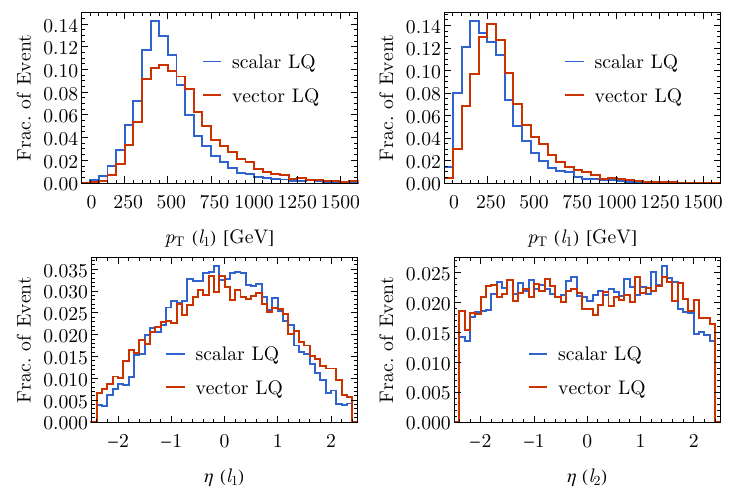
Figure 4. p T and (cid:17) distribution for the two electrons given m